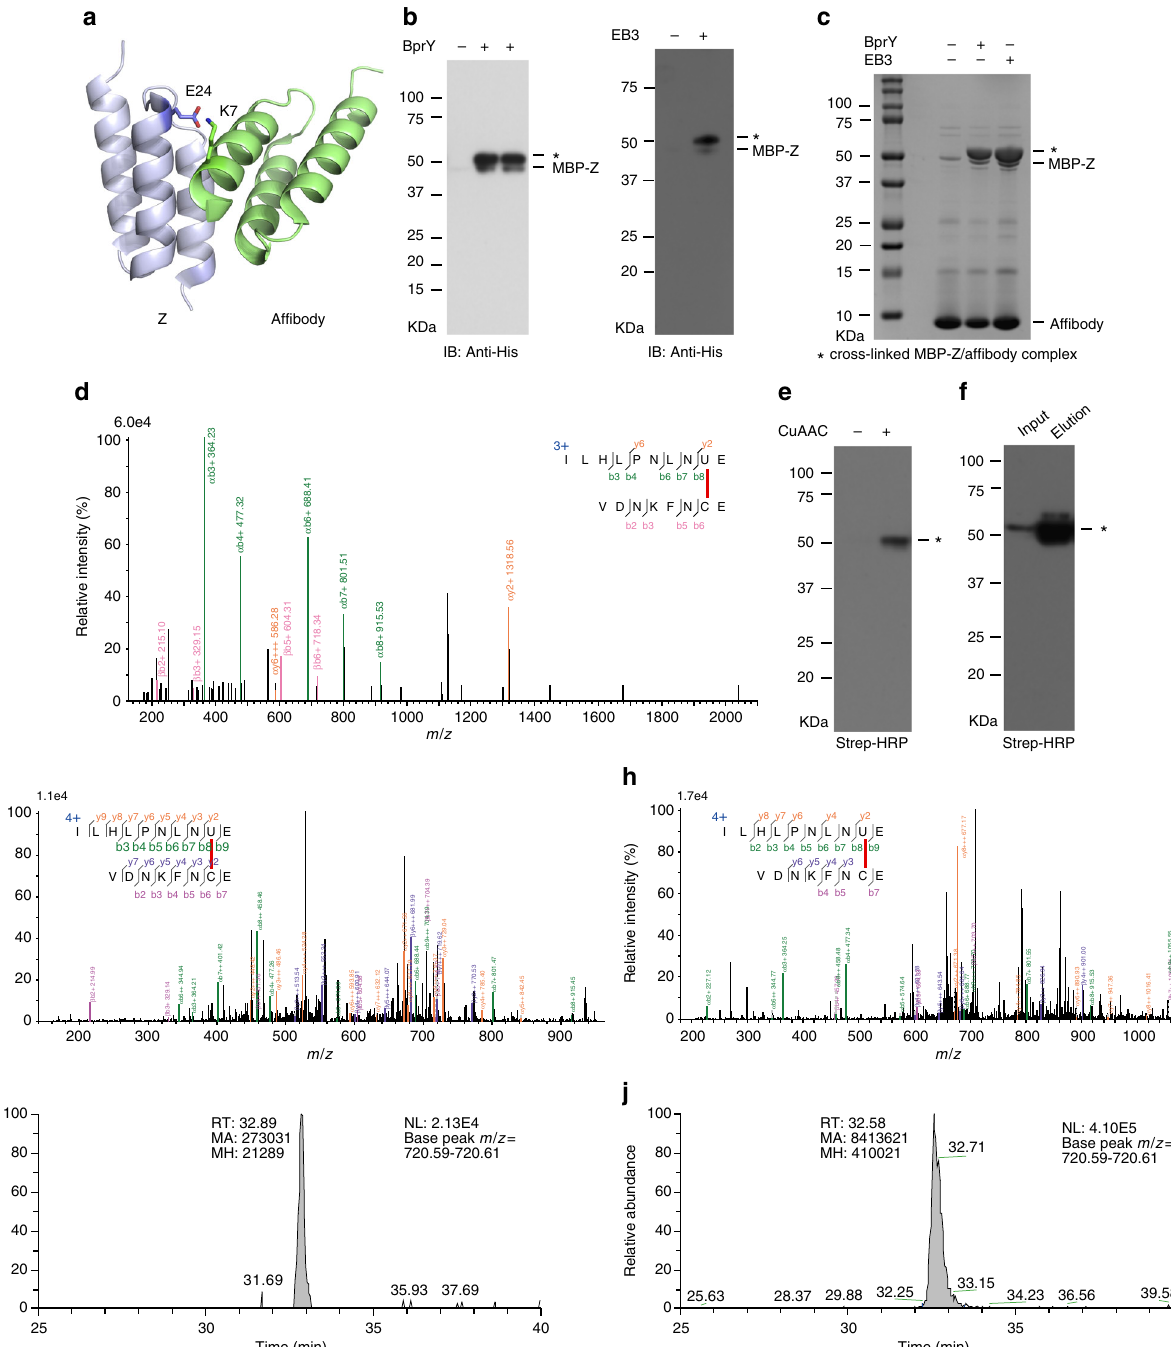
Fig. 2 GECX-MS to capture and identify af fi body binding to Z in E. coli . a Structure of the af fi body – Z protein complex (PDB ID 1LP1), with two proximal sites, Lys7 in the af fi body and Glu24 in the Z protein, highlighted. b Western blot of cell lysate of cells co-expressing MPB-Z(24BprY) with af fi body(7Cys) and of cells co-expressing MPB-Z(24EB3) with af fi body(7Cys). The cross-linked MBP – Z/af fi body complex is indicated with a star. c SDS-PAGE of proteins His- tag puri fi ed from cells co-expressing af fi body(7Cys) with MPB-Z(24BprY), or with MBP-Z(24EB3). In the absence of Uaa, background suppression of the TAG codon at site 24 resulted in small amount of full-length MBP – Z. d Mass spectrum of the cross-linked peptide between af fi body(7Cys) and MBP-Z (24BprY). U represents BprY in the peptide sequence. e His-tag puri fi ed af fi body(7Cys)/MBP-Z(24EB3) was labeled with biotin via CuAAC and then western blotted with streptavidin-HRP conjugate. f Biotin based enrichment of cross-linked af fi body(7Cys)/MBP-Z(24EB3). g Mass spectrum of the cross- linked peptide between af fi body(7Cys) and MBP-Z(24EB3) before biotin labeling. U represents EB3 in the peptide sequence. h Mass spectrum of biotinylated cross-linked peptide between af fi body(7Cys) and MBP-Z(24EB3). U represents EB3 in the peptide sequence. i Extracted ion chromatography of biotinylated cross-linked peptide from input sample of biotin enrichment. j Extracted ion chromatography of biotinylated cross-linked peptide from elute sample of biotin enrichment. RT retention time, MA peak area, MH peak height